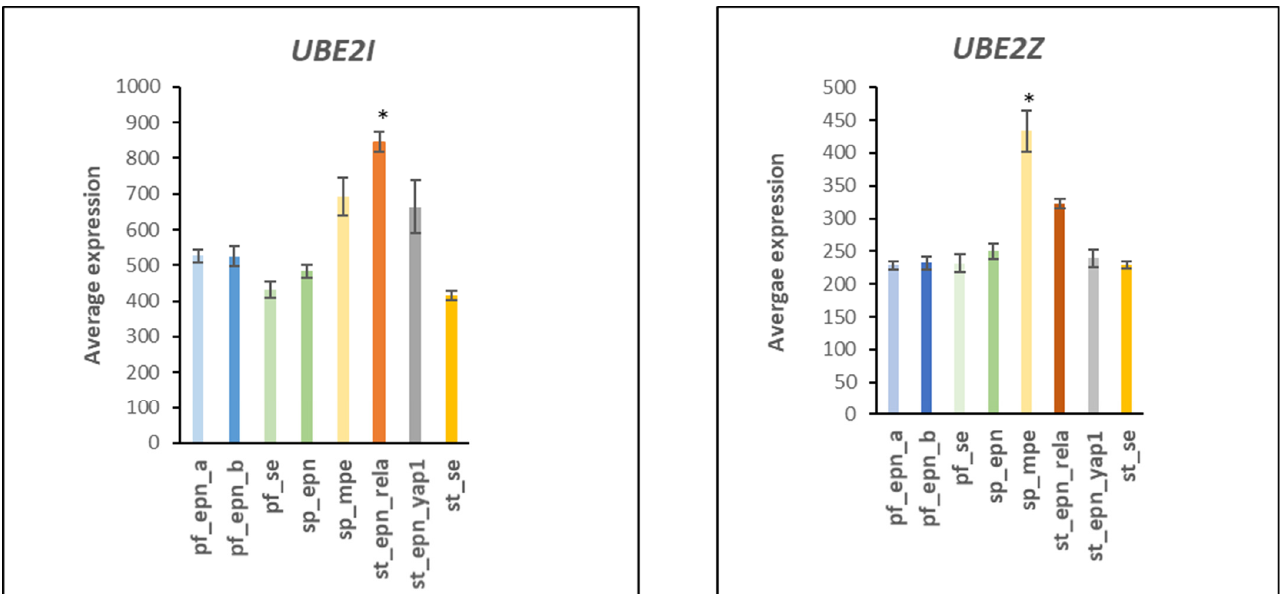
Figure 4. * By t -test UBE2I mean of the St_Epn_Rela group is significantly greater (by Anova, F = 22.36, p = 3.06 × 10 − 22 ) than that of all other groups by at least p < 0.05. The most significant difference was between the PF-EPN-A and the RELA groups (t = 9.88, p < 0.0001). By t -test mean of UBE2Z SP_MPE is significantly greater than that of all other groups, p < 0.0001. By Anova of UBE2Z , F = 28.73, p = 3.14 × 10 − 27 . Dataset GSE64415.